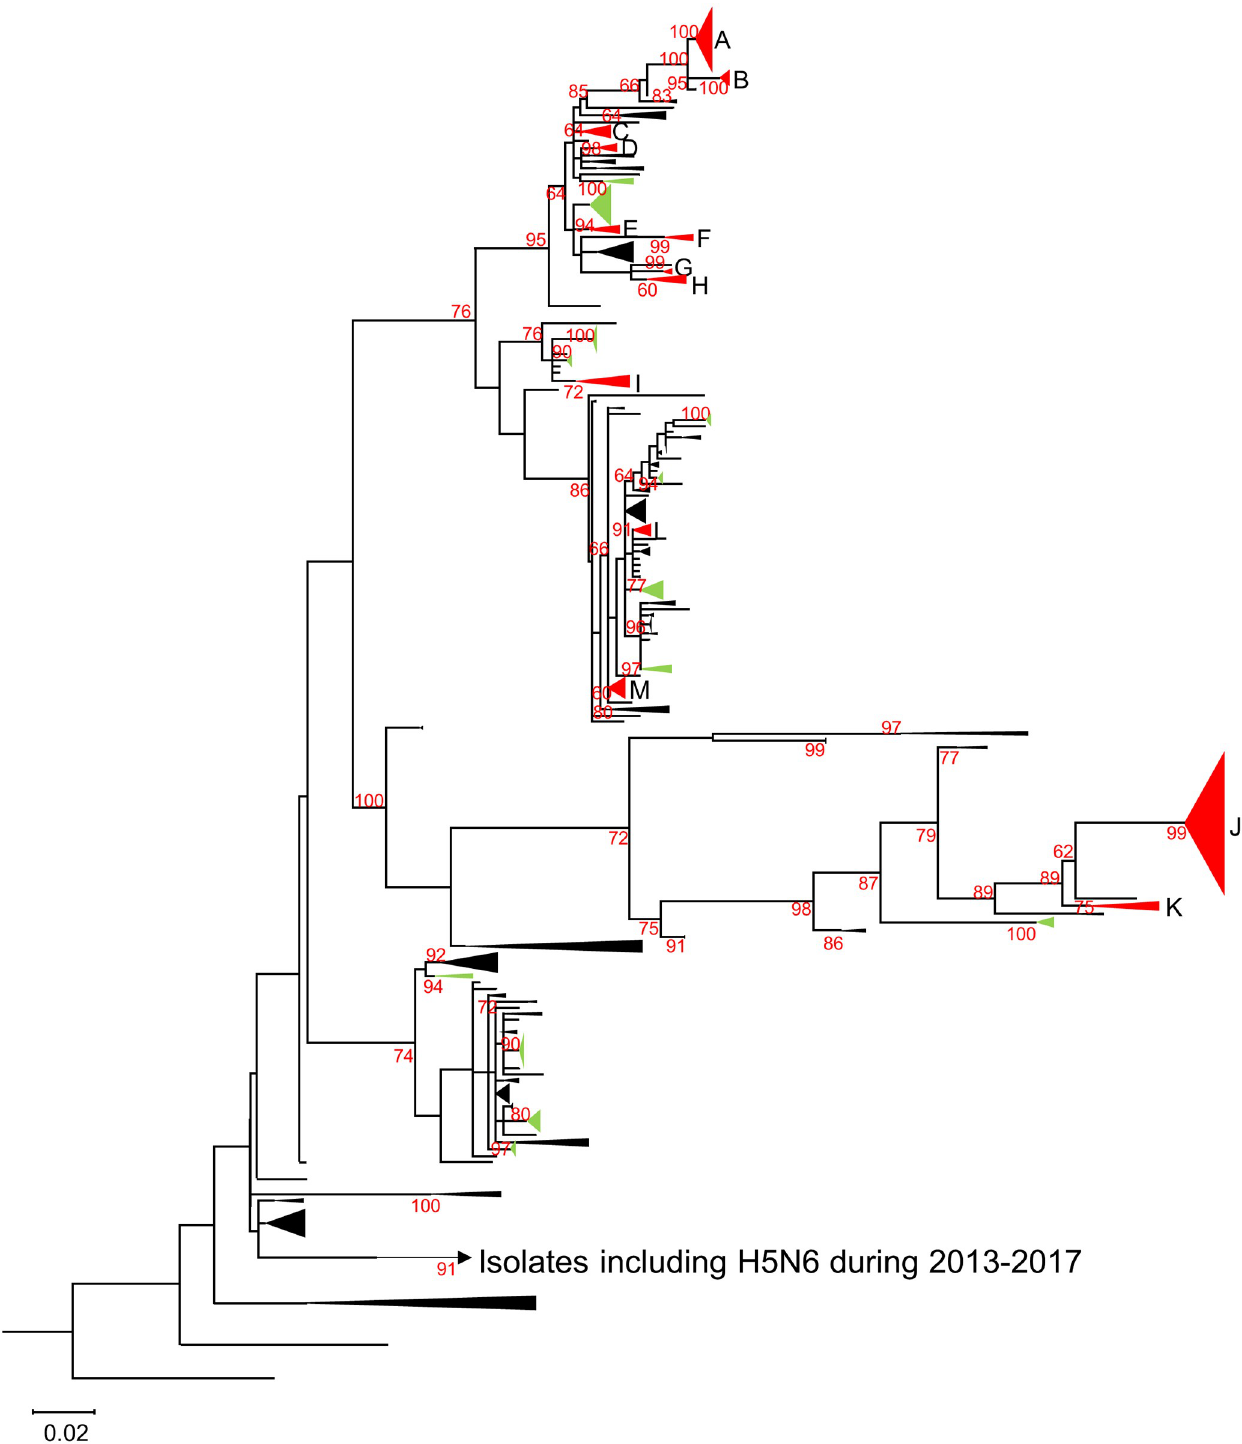
Fig 1. Entire N6 NA maximum likelihood phylogenetic tree composed of genes of viruses analyzed in this study and downloaded from the GISAID databases. AIVs classified as the Eurasian lineage are shown. Identified clades defined on the basis of the rule in this study are in green and red; red clades were selected for phylogeographic analysis and correlation analyses of bird host species and subtypes with phylogeny.